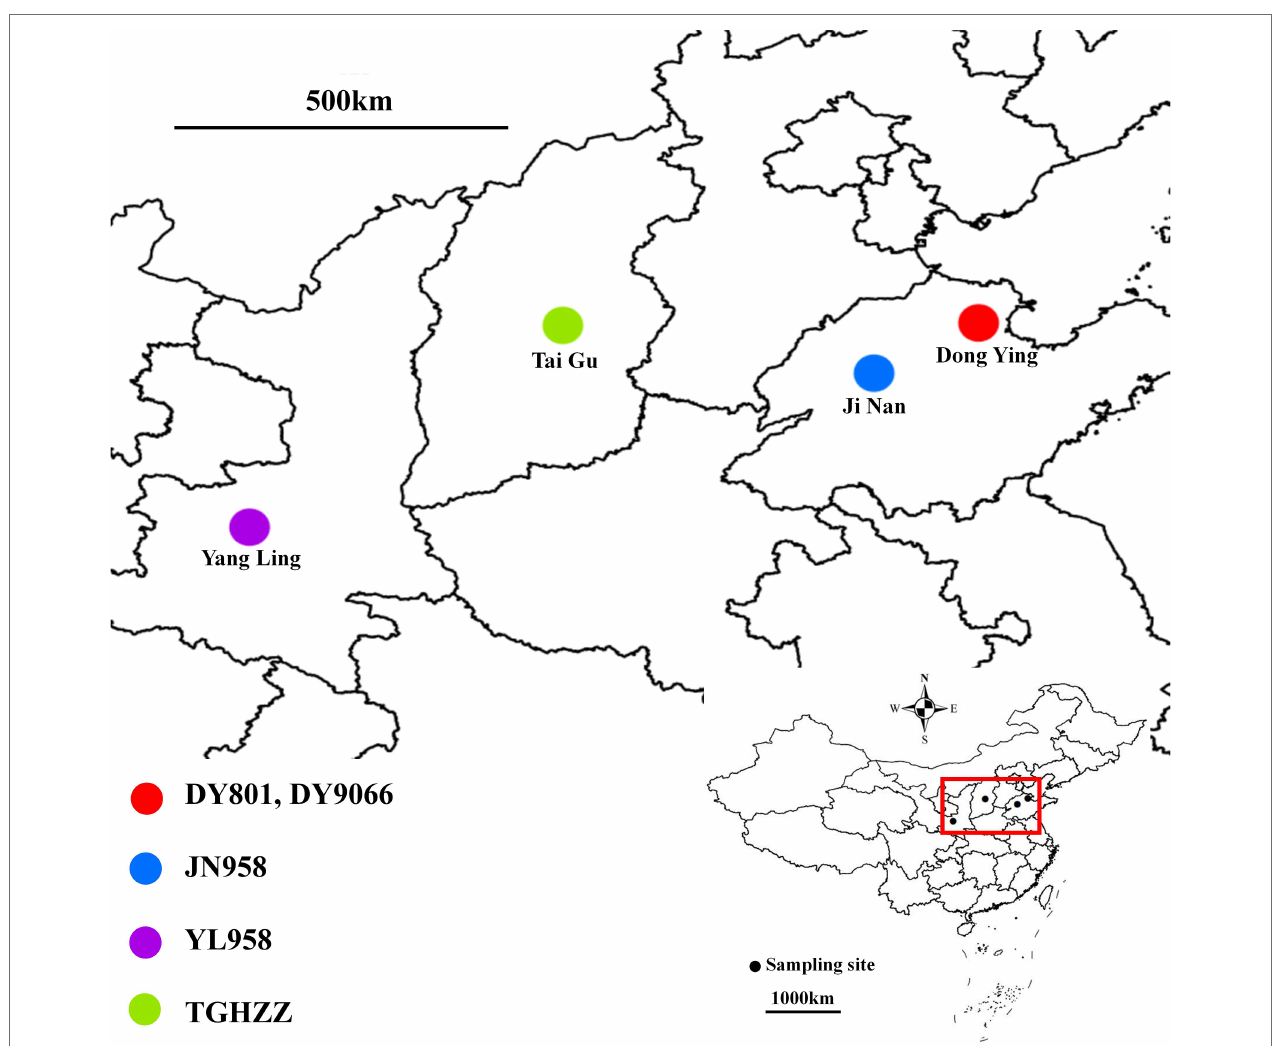
FIGURE 1 | Collection sites of the five caterpillar populations in this study. DY801 and DY9066 referred to the two populations being collected on two maize varieties (Ludan 801 and Ludan 9,066) at one site, Dong Ying, Shandong. JN958 and YL958 referred to the two populations being collected on a single maize variety (Zhengdan 958) at two sites, Ji Nan, Shandong and Yang Ling, Shaanxi. TGHZZ referred to the population being collected on the maize variety of Heizhenzhu in the city of Tai Gu in Shanxi